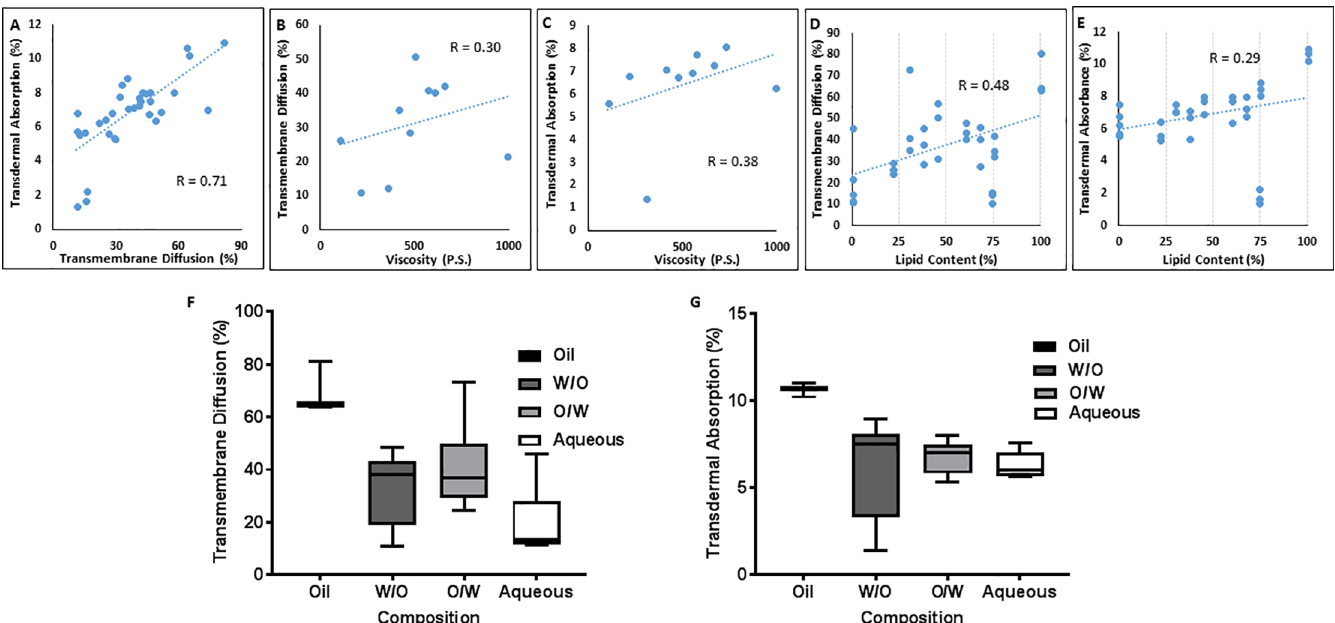
Fig 3. Analysis of data. Statistical analysis of the in vitro and ex-vivo performance of the formulation library, including the correlation between viscosity and transmembrane diffusion as well as transdermal absorption (A and B, respectively), lipid content and transmembrane diffusion as well as transdermal absorption (C and D, respectively), the extent of transdermal diffusion at 12 hours and the percentage of transdermal absorption at the same time point (E), and a box graph comparison of the mean diffusion and absorption for different category of formulations (F and G, respectively). R represents the correlation coefficient.